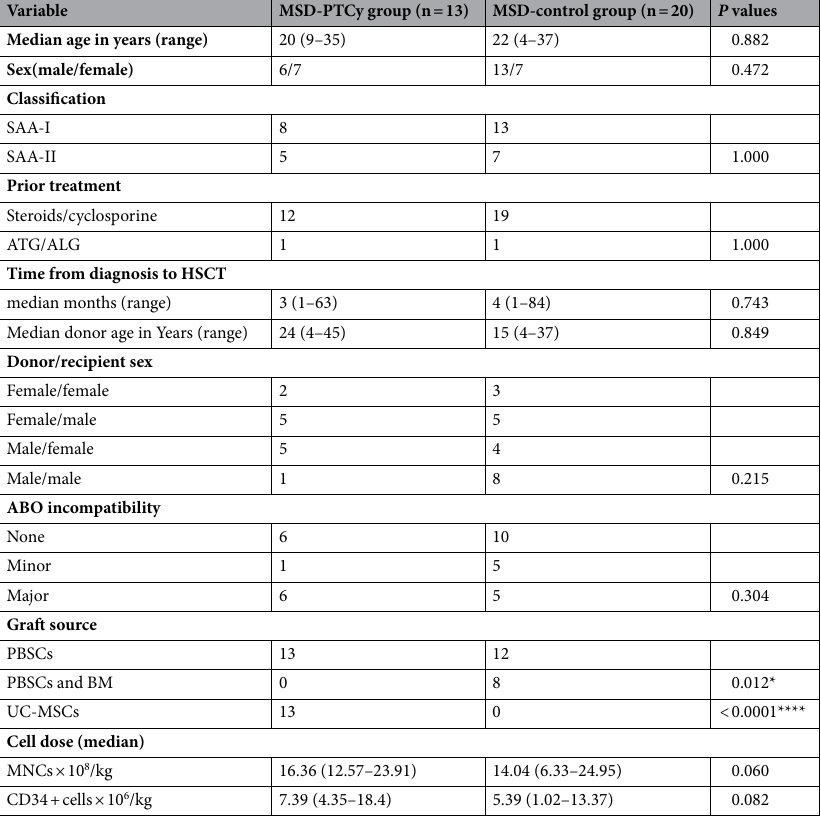
Table 1. Patient characteristics and transplant-related parameters in the MSD-HSCT groups. Continuous variables were expressed as median values and ranges; Discrete variables were expressed as counts (%). P -value from Fisher exact test and independent samples T test. * P < 0.05, **** P <